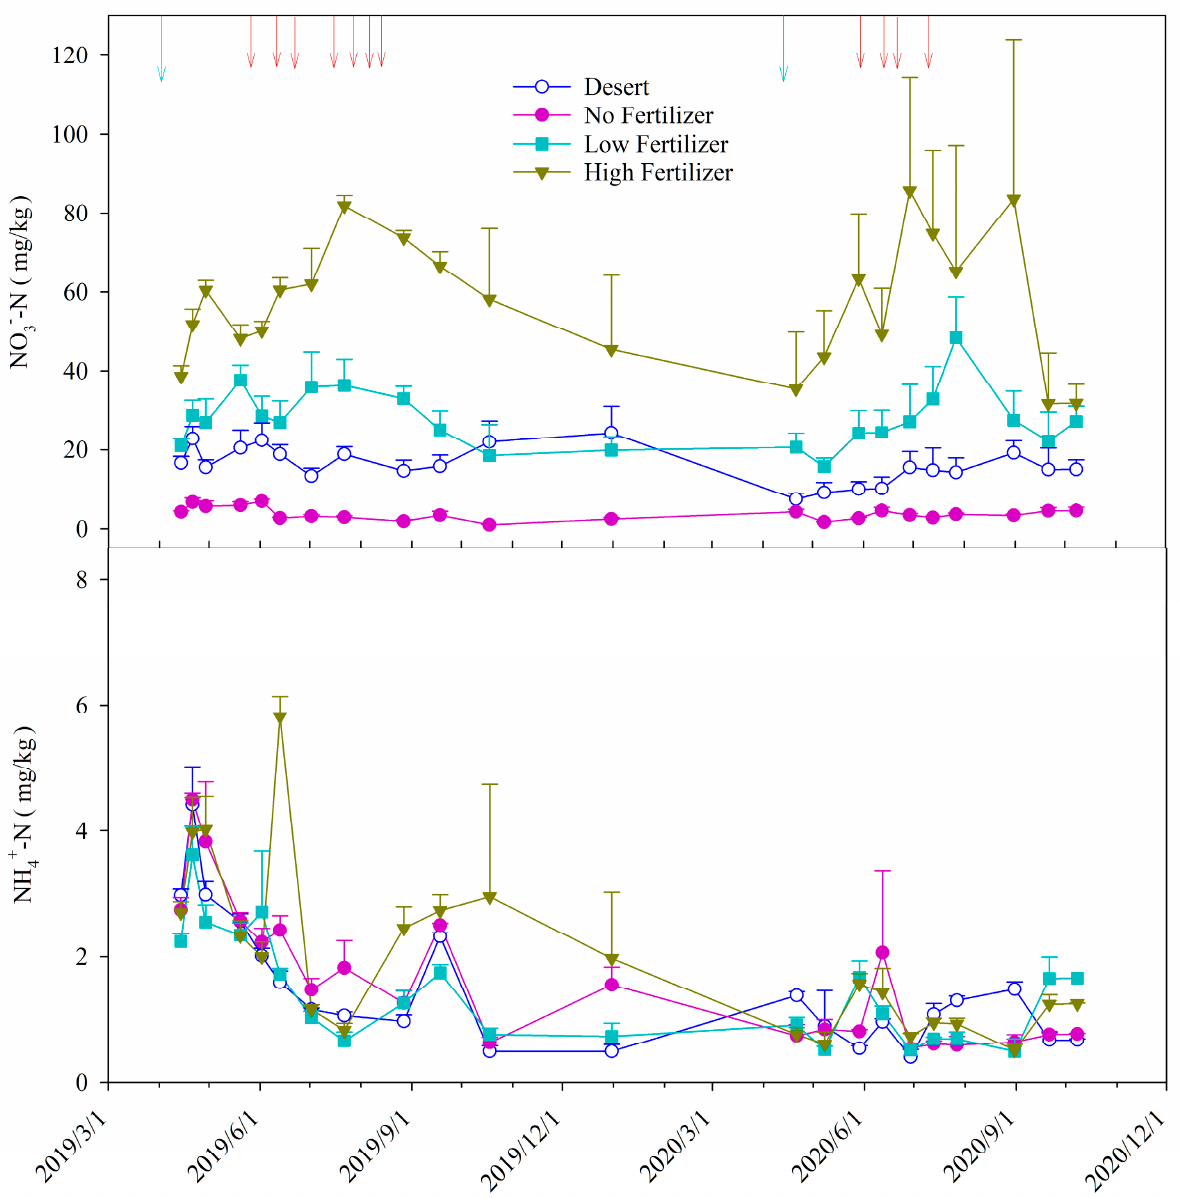
Figure 3. Dynamic changes of soil concentrations of NH 4+ − N and NO 3 − − N as affected by land reclamation and fertilizer input treatments. Blue arrows indicate the date of planting and basal fertilizer application and red arrows indicate the dates of drip fertigation. Bars indicate the +1 standard error of the mean, n =